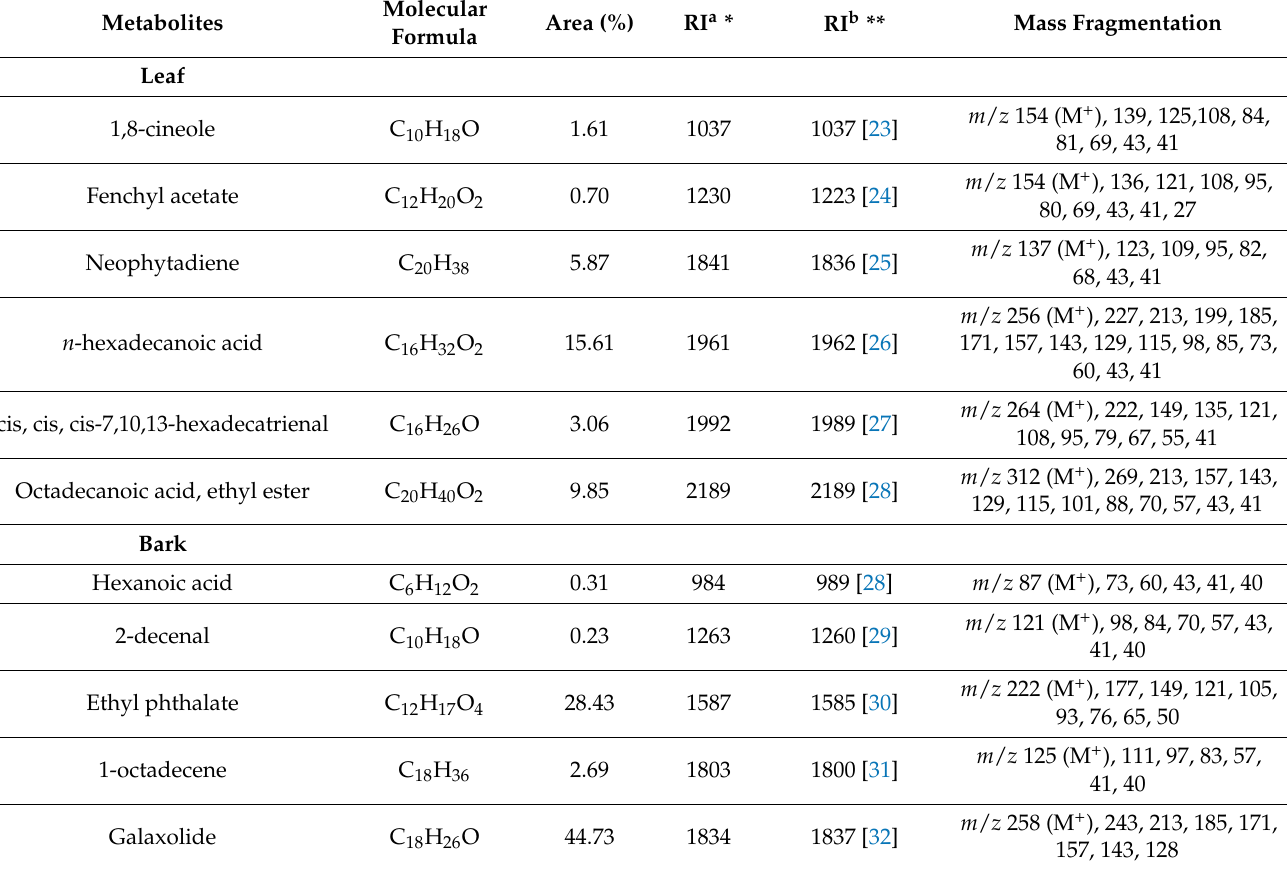
Table 2. Chemical composition of n -hexane fraction from leaves and bark of Triadica sebifera .